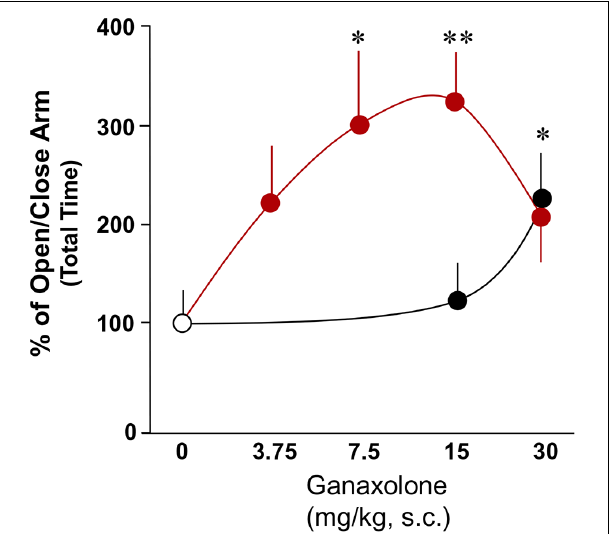
FIGURE 3 |The effects of ganaxolone on anxiety-like behavior in SI mice (red circles) results in a bell shaped dose–response curve, which is shifted to the right in group-housed mice (black circles). Ganaxolone in the dose range of 3.75–30 mg/kg improves anxiety-like behavior of SI mice exposed to an elevated plus maze and assessed by open to close arm total time, and improved anxiety-like behavior of group-housed mice at the high dose of 30 mg/kg, s.c. Data represent the mean ± SEM of eight to fourteen mice. * P < 0.05; ** P < 0.01 when compared with vehicle-treated (0)